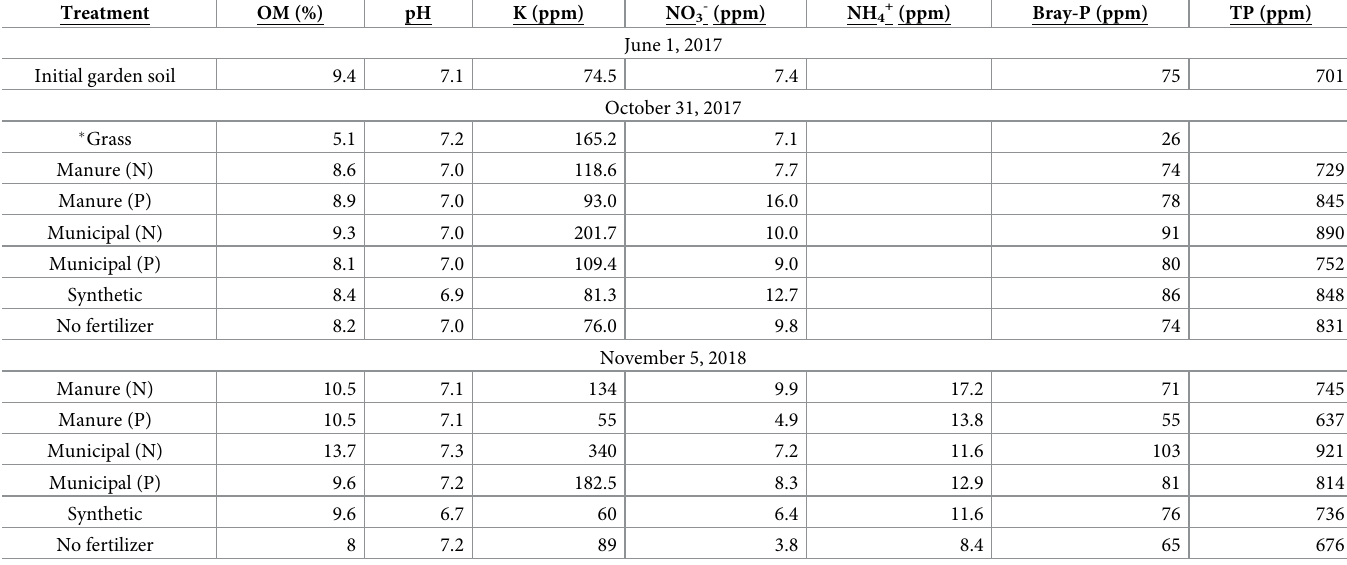
� Grass included for